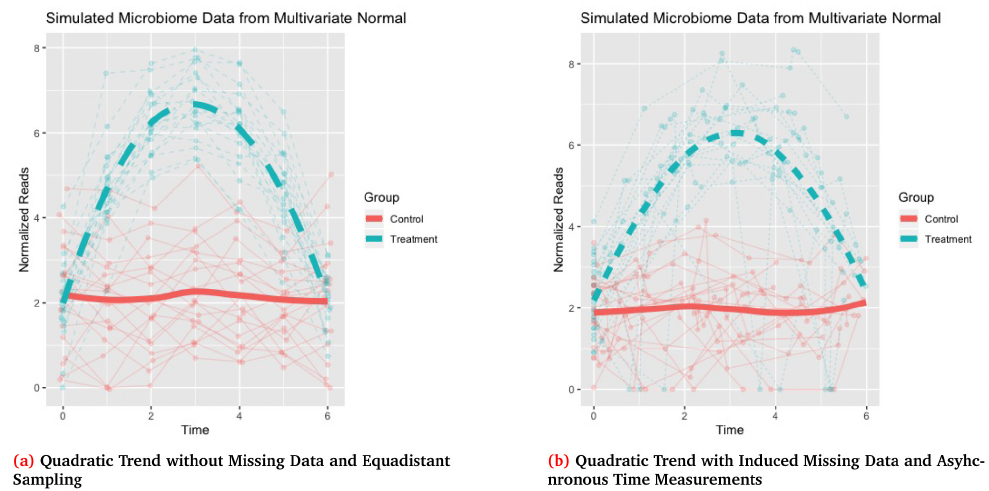
Figure 2. Simulating a quadratic differential abundance trend with compound correlation structure and parameters: β = (0, 3, − 0.5) T , ρ = 0.7, σ = 1, n = n = 20, q = 6. Missing data in Figure 2b is generated with 20% 0 1 of subjects randomly selected to have missing values and for each of these subjects to have 2 non-baseline times randomly selected to be missing with the missing observations imputed as